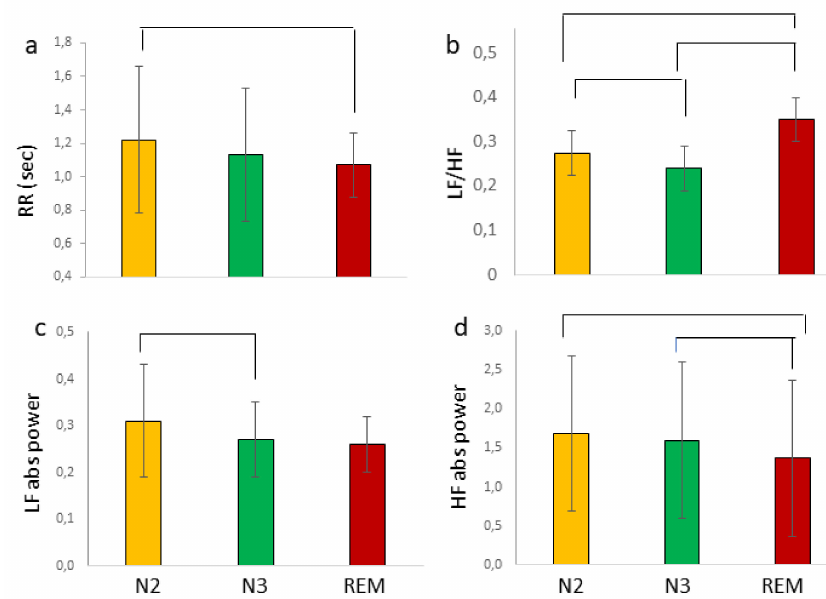
Figure 1. Autonomic states during sleep. Lines indicate significant differences between sleep stages for RR ( a ), LF/HF ( b ), LF absolute power ( c ), and HF ( d ) absolute power (mean, SD). SDNN exhibited a significant stage effect (F(2,31) = 7.249, p = 0.007, η 2 = 0.200), with higher values during N2 (mean ± sd (sec); 0.12 ± 0.11) than N3 (mean ± sd; 0.08 ± 0.05; F(1,31) = 5.769, p = 0.023), and during REM (mean +SD (s); 0.13 ± 0.12) than